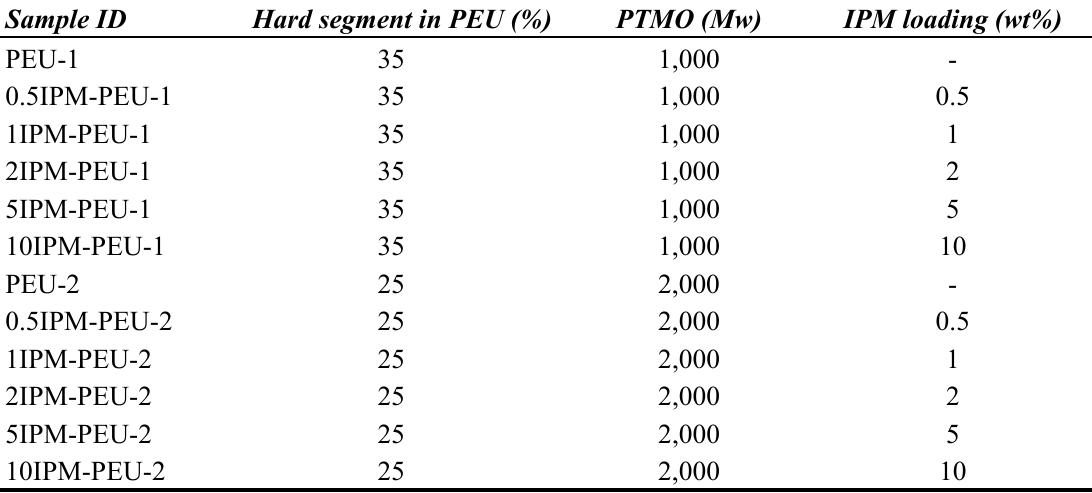
Table 1. IPM loaded polyether-urethanes (combination as used in